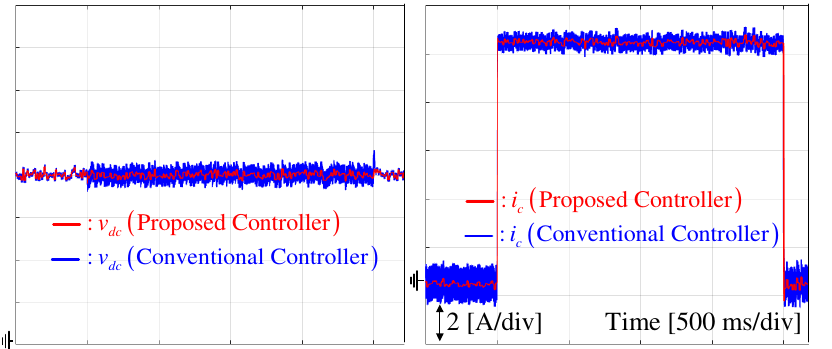
Figure 13. Output voltage and inductor current ripple level comparison at f vc = 30 Hz and constant reference regulation mode of v dc , ref = 50